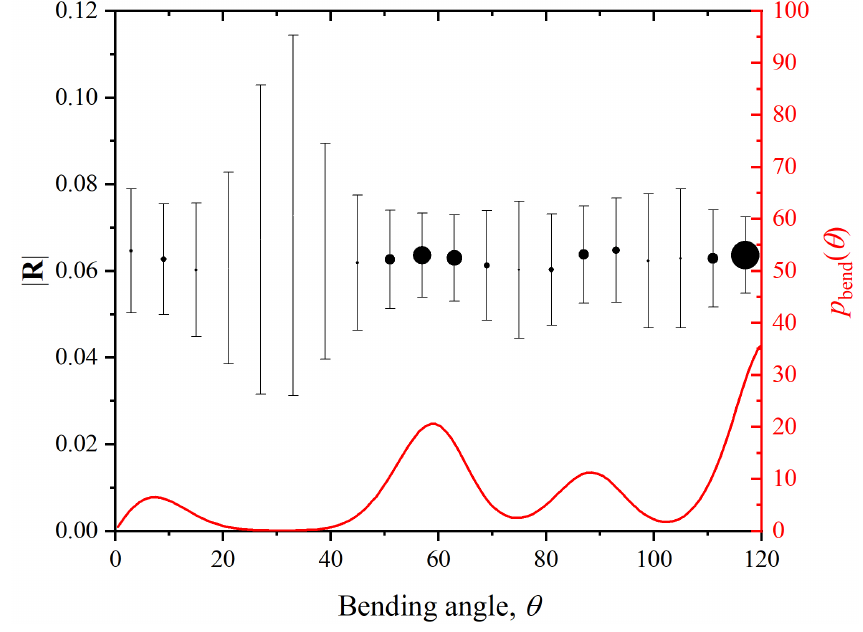
Figure 3. Left y -axis (black color): Distance | R | between a monomer and the centroid of its Voronoi cell, versus the bending angle θ of the monomer, averaged over Region IV. Symbol size is proportional to the frequency of occurrence of the corresponding bending angle θ . Right y -axis (red color): the probability distribution of bending angles. Error bars are fluctuation amplitudes, angles have been grouped in 20